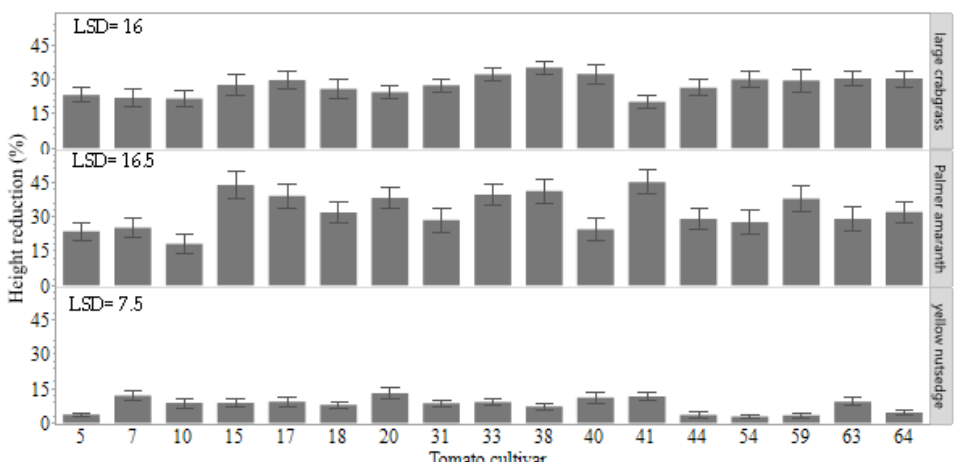
Figure 3. Weed-suppressive ability of tomato cultivars on height reduction (%) and chlorophyll reduction (%) of Palmer amaranth, large crabgrass, and yellow nutsedge at 28 days after sowing. Four tomato plants and four plants of a single weed species were grown together in the same pot. The reduction values were based on a comparison to plants of individual weed species grown as a control treatment without tomato interference. Error bars represent the standard deviation of the mean. The difference between the two mean values is compared to the least significant difference (LSD) value. If the difference was greater than the LSD value, then the means are significantly different according to Student’s t -test at a 0.05 probability level.